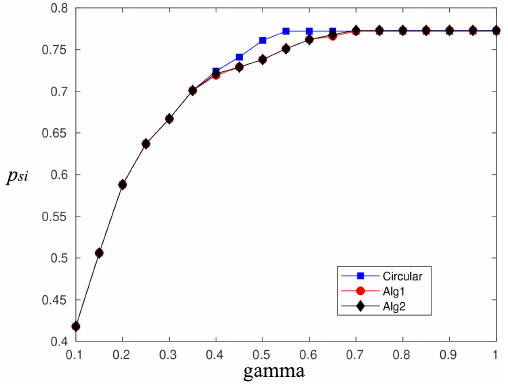
Figure 10. p si —Compare sector selection strategies for β =